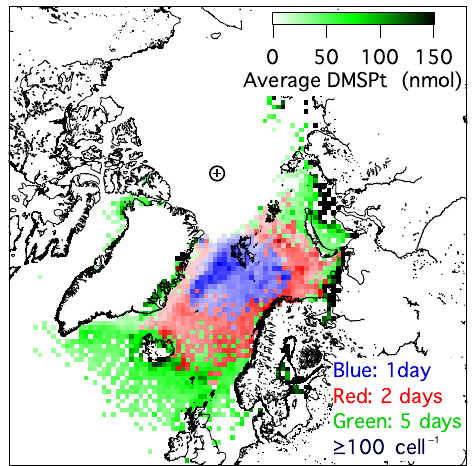
Figure 3. Map of the regional distribution of DMSPt along 87648 5-day (green), 2-day (red), and 1-day (blue) hourly back trajectories to Mt. Zeppelin during the during the months March through Octo- ber of the years 2006–2015. Black cross in a circle: North Pole. The relative color scale holds for all colors. The areas are covered with at least 100 trajectory hours with data values per